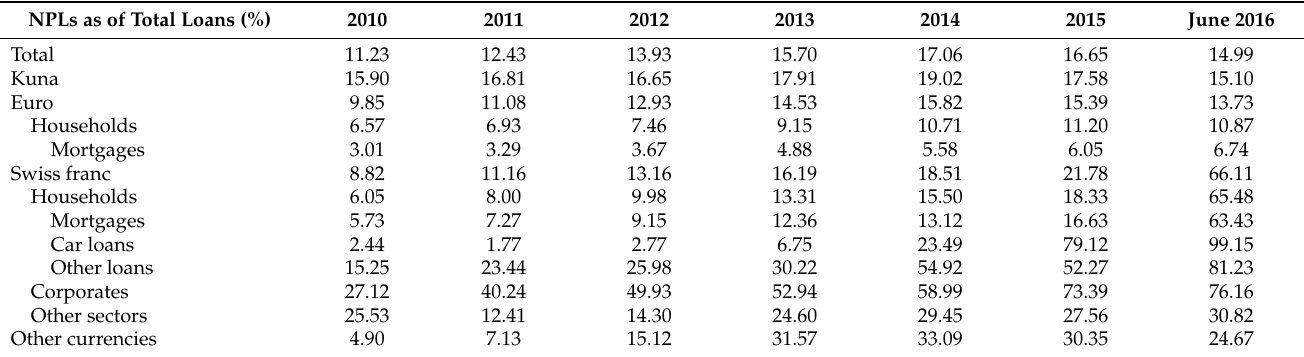
Table 2. Loan quality (in %) by currencies, sectors and loan purpose in Croatia, 2010–2016. NPLs as of Total Loans